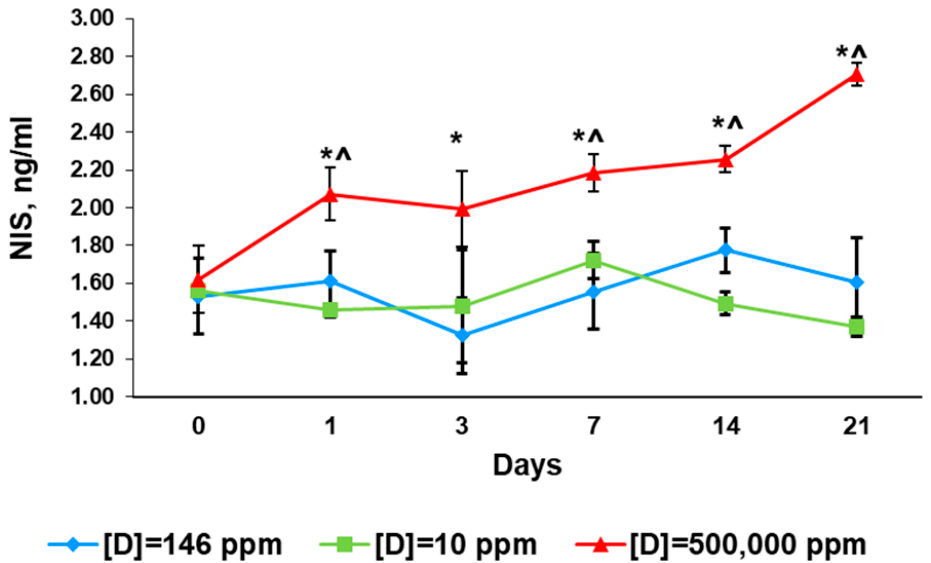
Figure 5. Serum concentration of NIS in the rats that consumed water with modified deuterium content for 21 days. Data are shown as mean ± S.E.M.; p < 0.05 compared to the control (*) and to the rats that consumed water with [D] = 10 ppm (^).